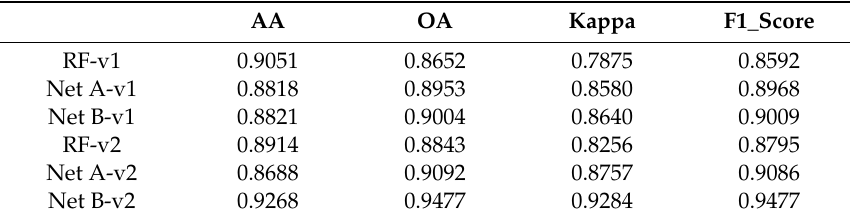
Table 6. Results of study area 1 (v1 is amplitude data and v2 is covariance matrix data).